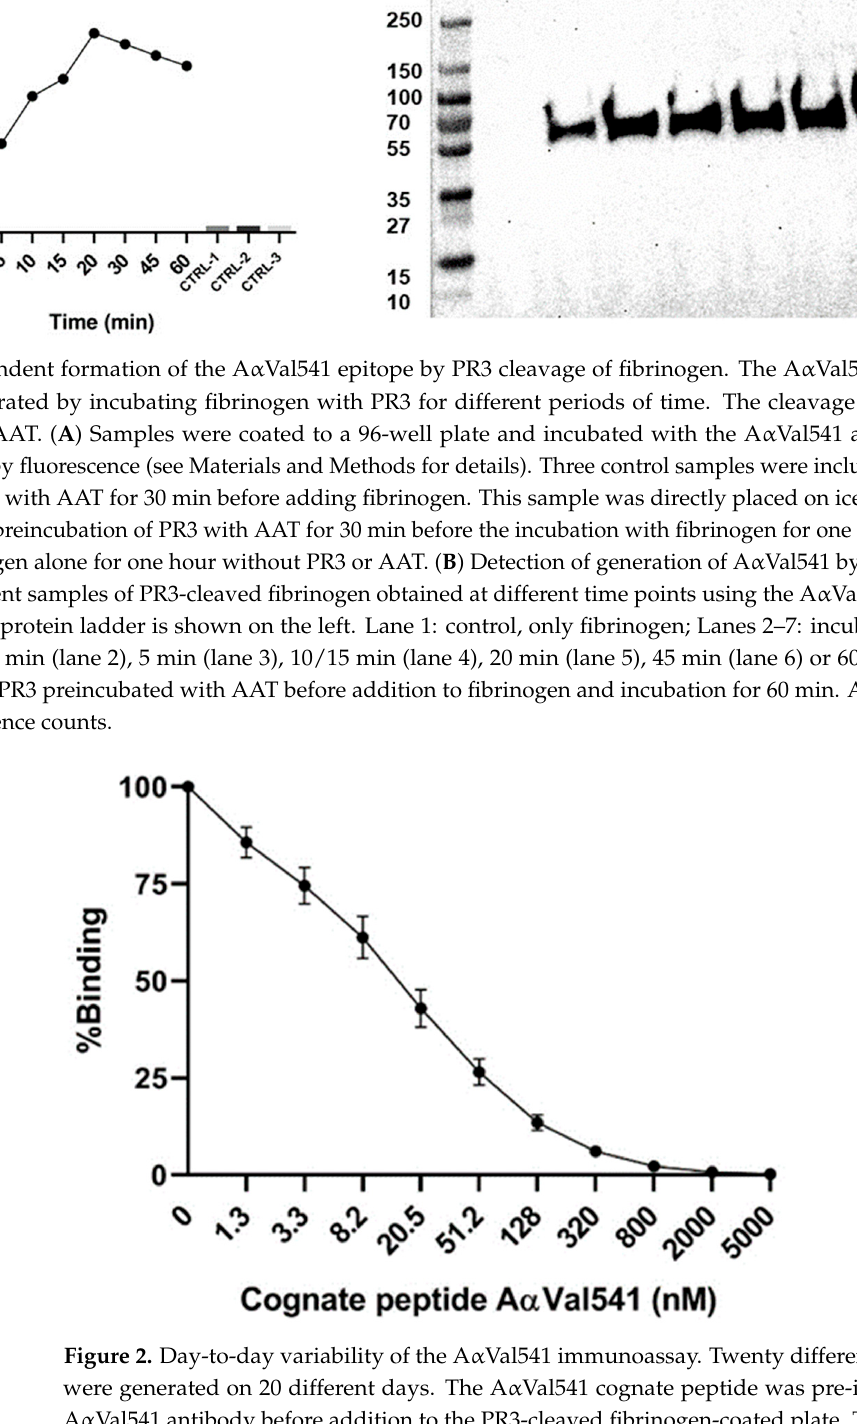
Figure 2. Day-to-day variability of the A α Val541 immunoassay. Twenty different standard curves